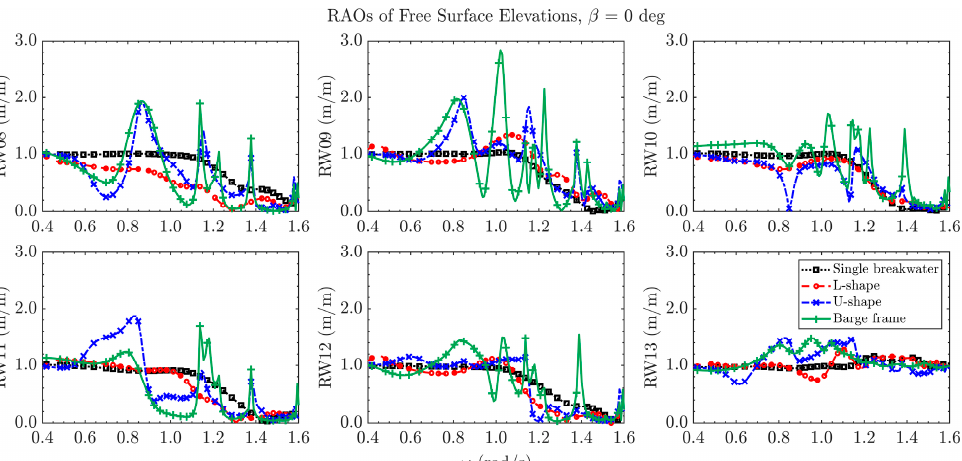
Figure 8. RAOs of free surface elevations at selected locations in the sheltered zone in 0 deg incident wave direction.